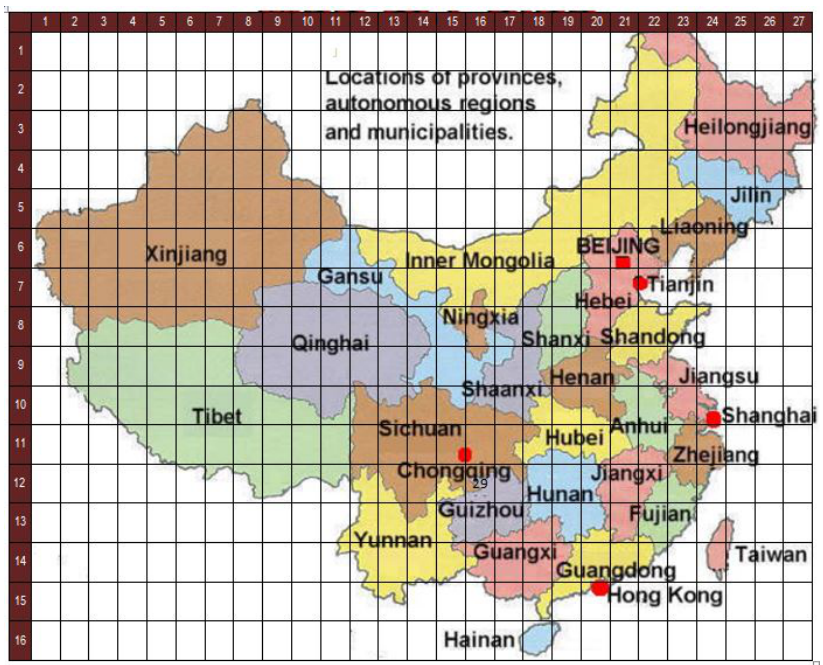
Figure 5. The configuration of regions of China in cellular space.